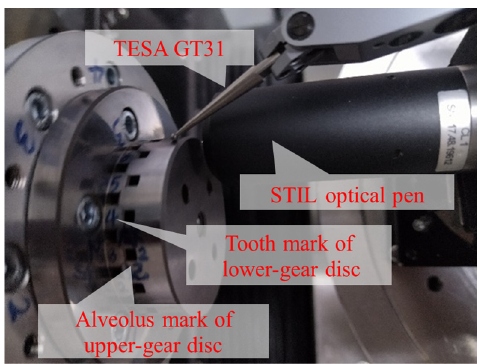
Figure 11. Configuration of the detection process.